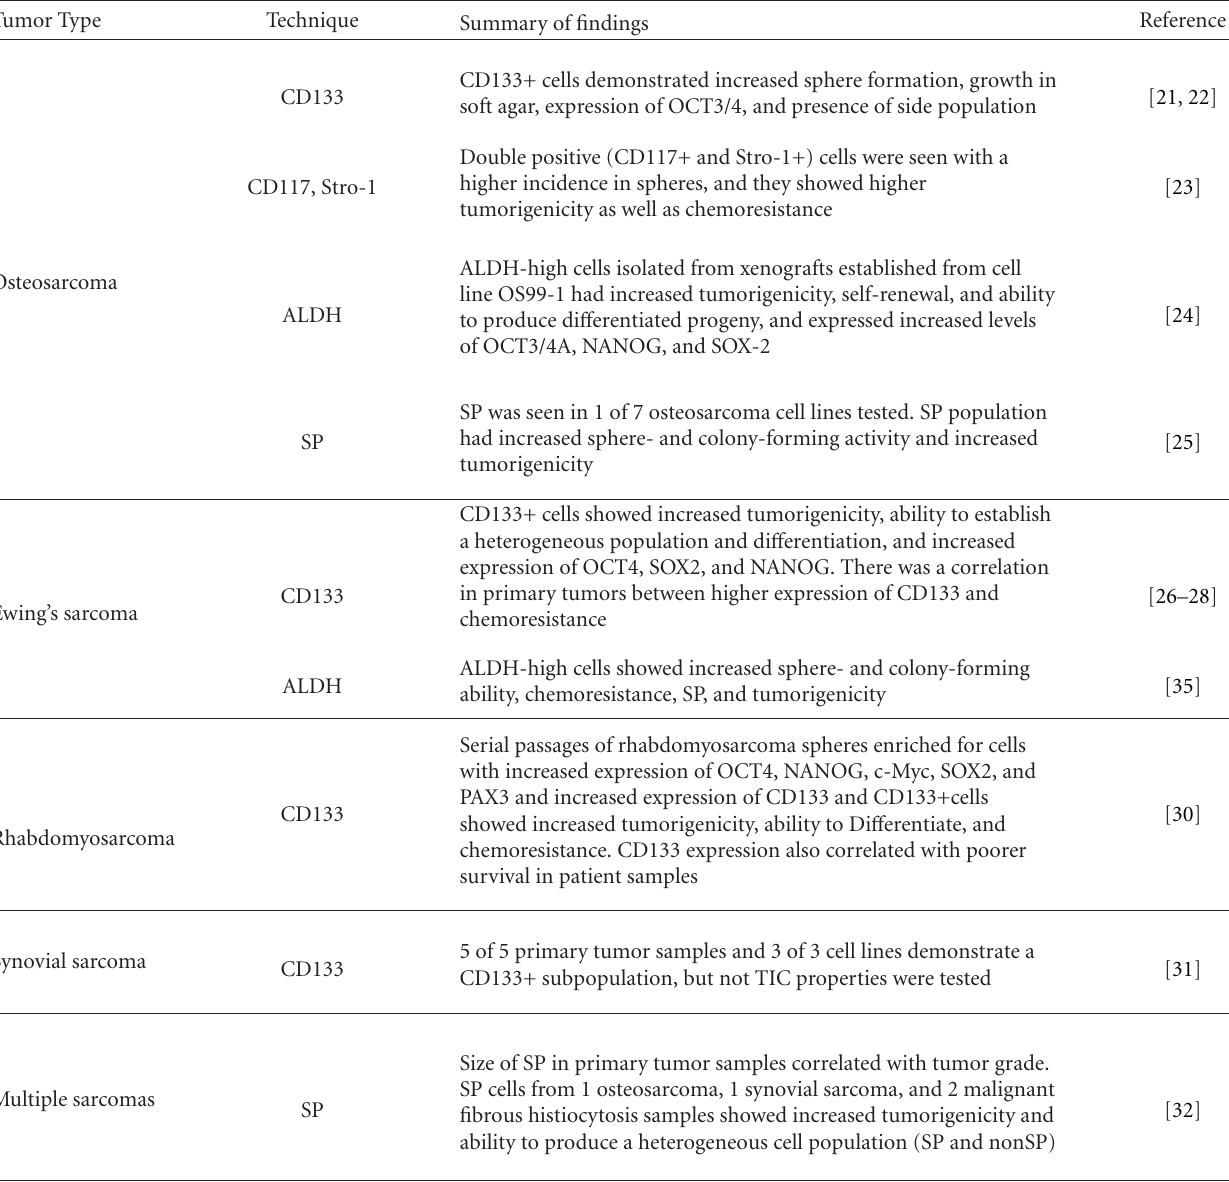
Table 2: Studies showing isolation of sarcoma-initiating